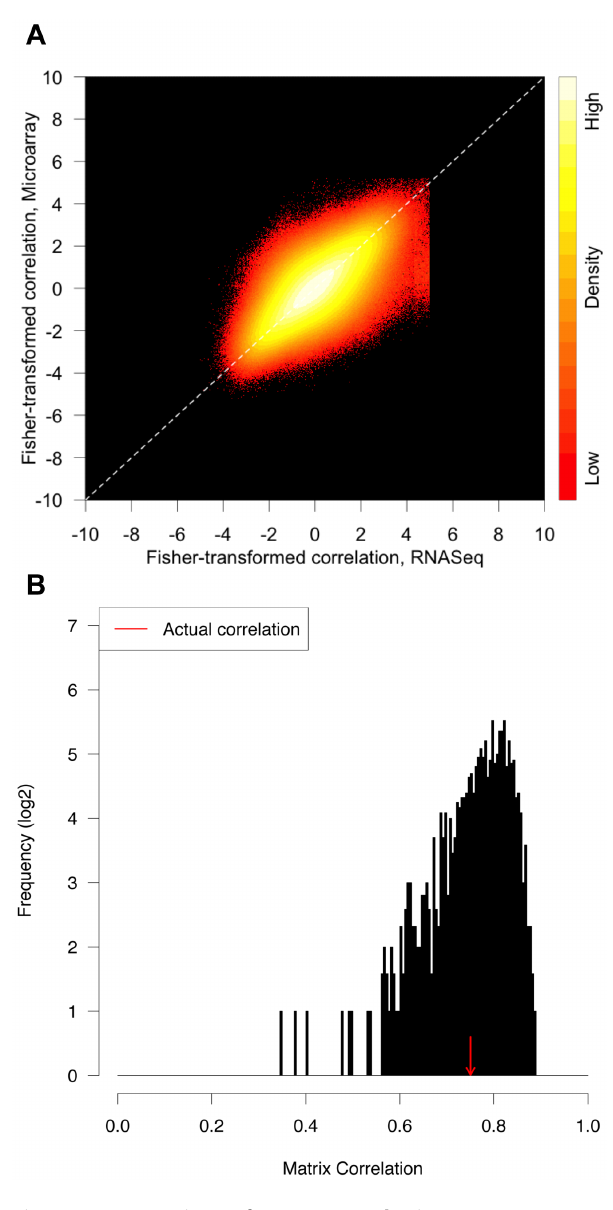
Figure 5. Comparison of RNA-Seq and microarray co-expres- sion networks. (A) The density of Fisher-transformed and normalized edge weights are shown for both the microarray (y-axis) and RNA-Seq (x-axis) co-expression networks. (B) The frequency of correlation coefficient (R) values for a series of 1000 random co-expression networks is plotted relative to the observed value (red arrow). The random co-expression networks were generated by selecting a mixture of RNA-Seq and microarray data for each of the two networks.